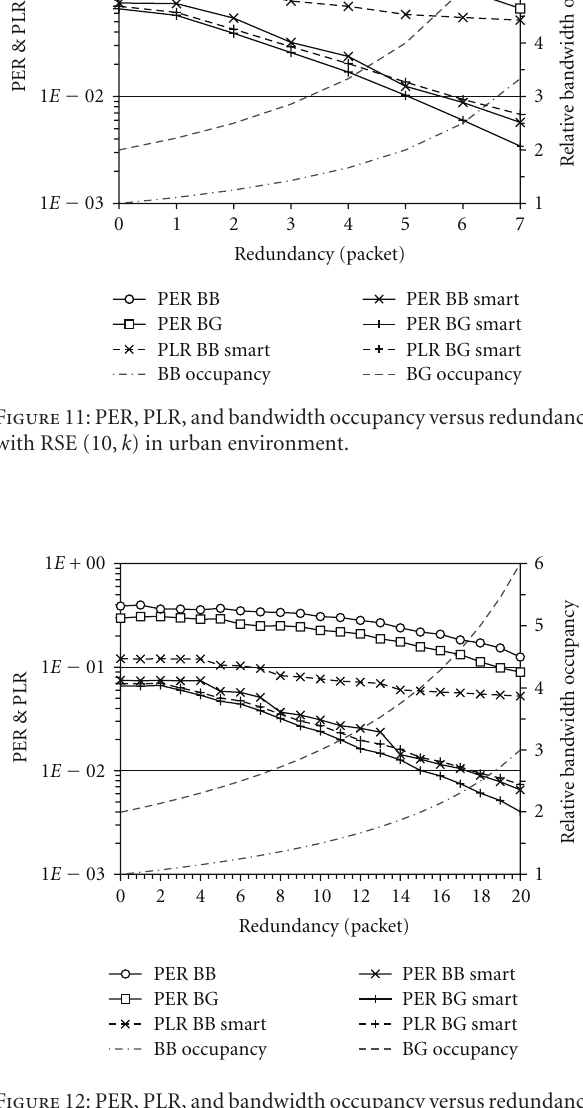
Figure 10: PER, PLR, and bandwidth occupancy versus redundancy with RSE (30, k ) in highway and rural environments.